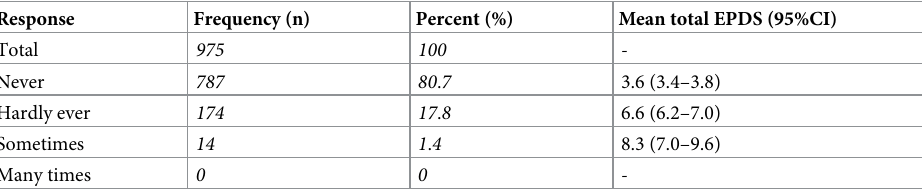
Table 3. EPDS question 10: “The thought of harming myself has occurred to